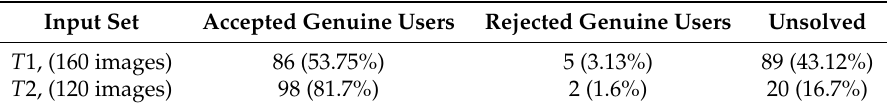
Table 1. Face recognition acceptance rates for genuine